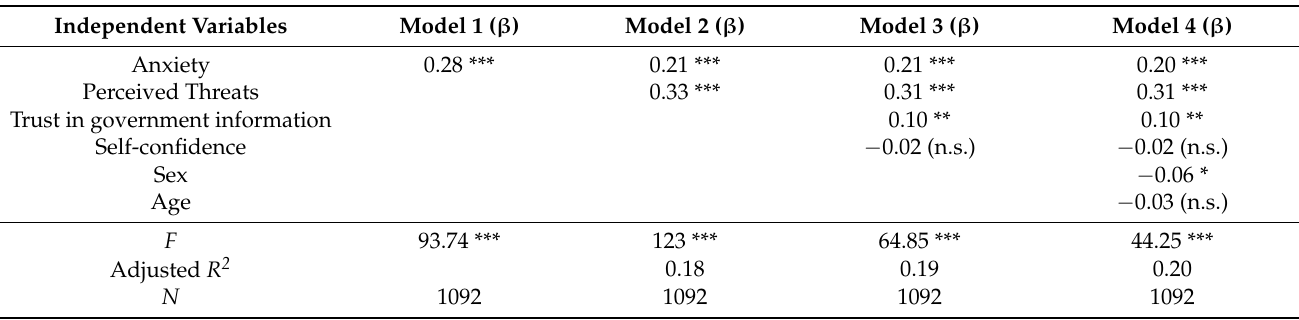
Table 4. Regressions